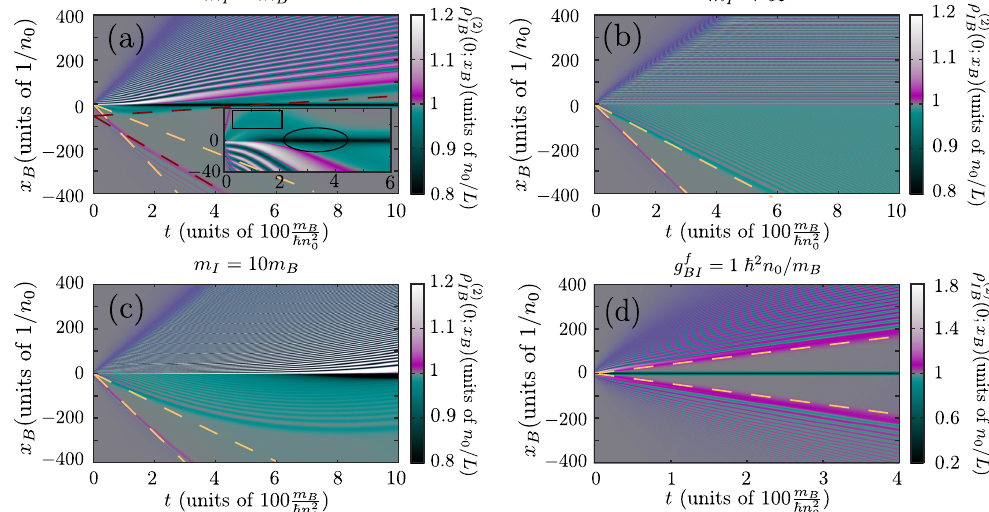
Figure 6. Dynamics of an initially supersonically moving impurity. ( a – c ) Spatiotemporal evolution of ( 2 ) ( 0; x ) , for a quench to g f = 0.07¯ h 2 n = 1¯ hn the bath-impurity correlation function, ρ B 0 / m B and p I 0 . IB BI The inset of ( a ) provides a magnification of the corresponding bath-impurity correlation function in the vicinity of the impurity. The mass of the impurity is provided in the corresponding labels, while g BB = 0.1¯ h 2 n 0 / m B , N B = 3200 and L = 3200 n − 1 . The light dashed lines indicate x I = ( ± c − p I / m I ) t 0 and the dark dashed lines in ( a ) correspond to x I = ( ± 1 − β f ) ct + x 0 , with β f = 0.7464 the final velocity of the polaron and x 0 = 64 n − 1 an offset selected for illustration purposes. ( d ) The time 0 ( 2 ) ( 0; x ) , for the same parameters as in ( a ) except for g f = 1¯ h 2 n evolution of ρ B 0 / m B . The trajectories IB BI indicated by the dashed lines correspond to x I = ( ± 1 − β f ) ct , with β f =